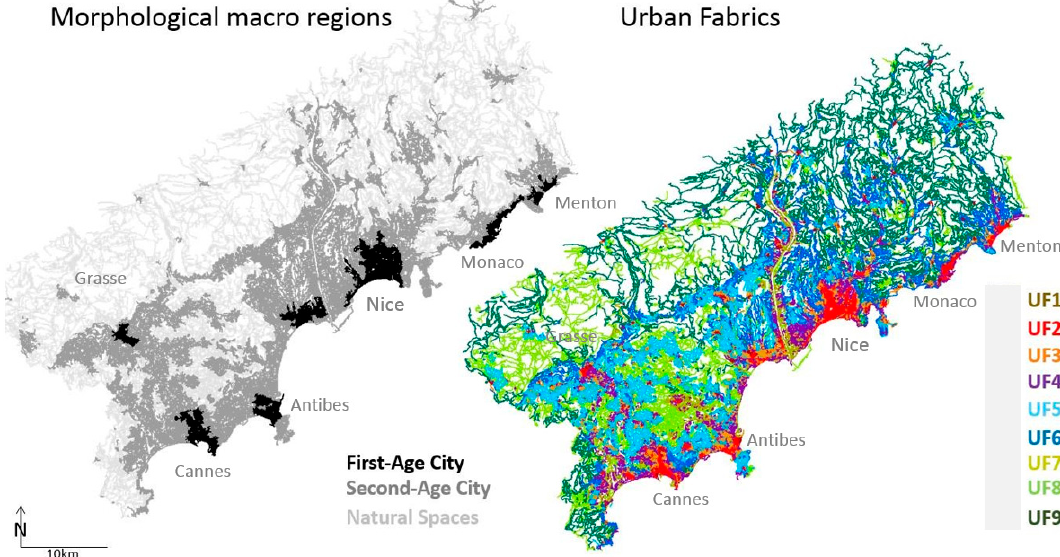
Figure 1. The French Riviera study region: the three morphological regions (First-/Second-Age City and Natural Spaces (left)) and the nine urban fabrics (UF1–9 (right)). Source: [56,57].